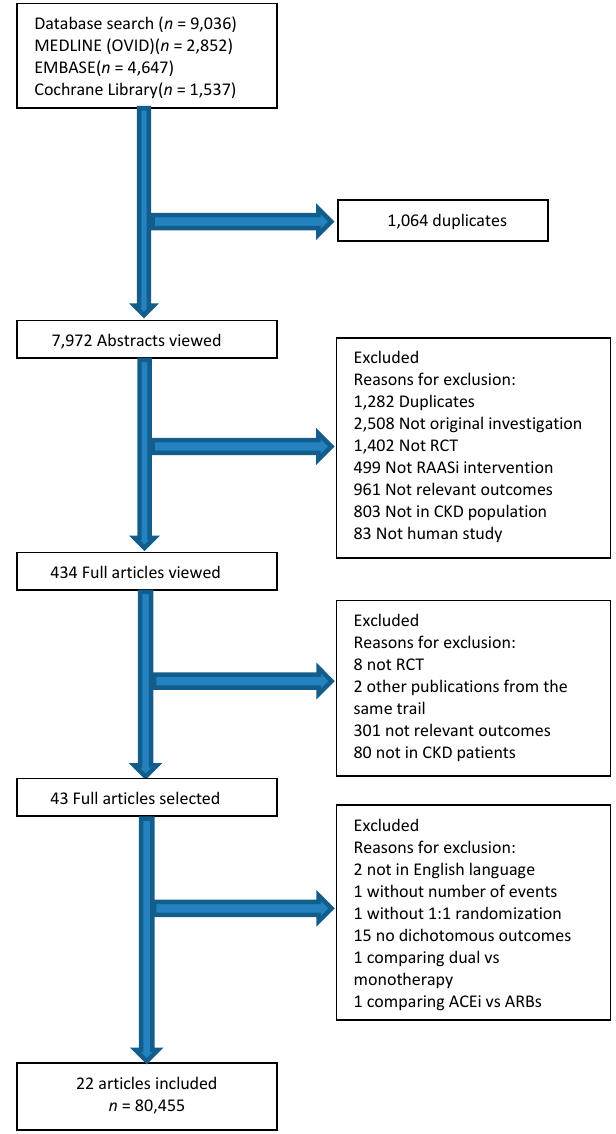
Figure 1. Flow diagram.